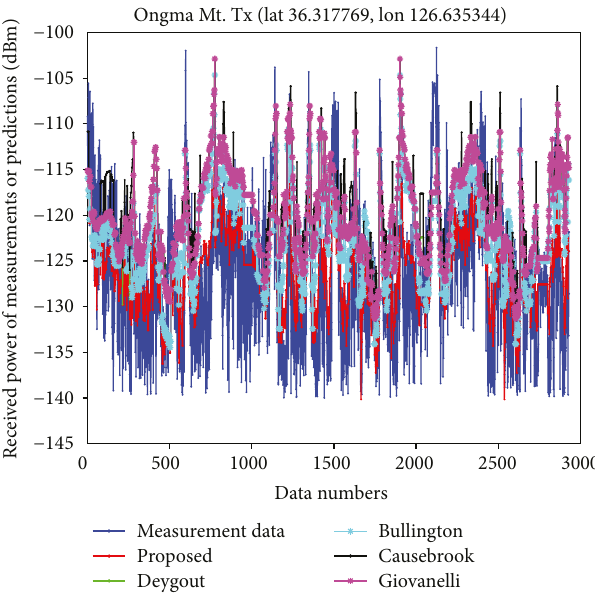
Figure 16: Comparison of the measurements and predictions in Mt.